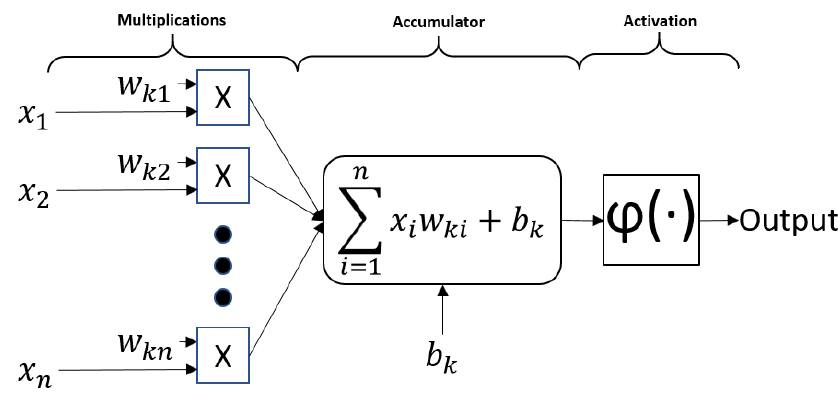
Figure 3. Structure of a neuron.